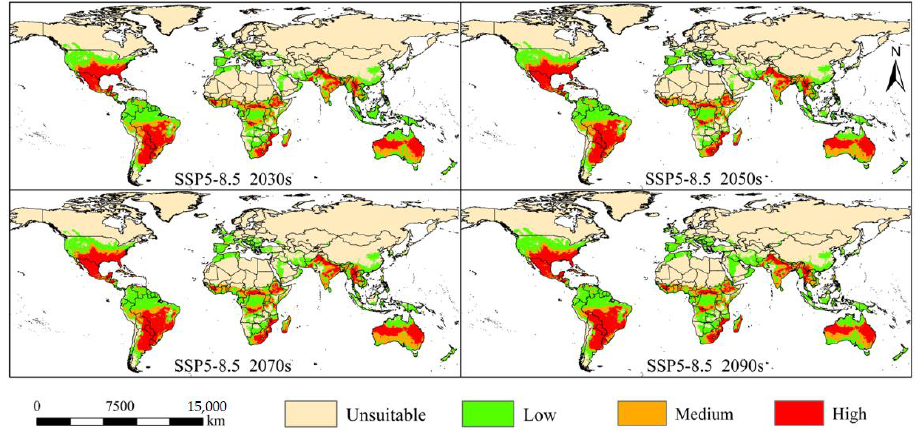
Figure 5. Current global distribution of suitable habitats of Anthonomus grandis .